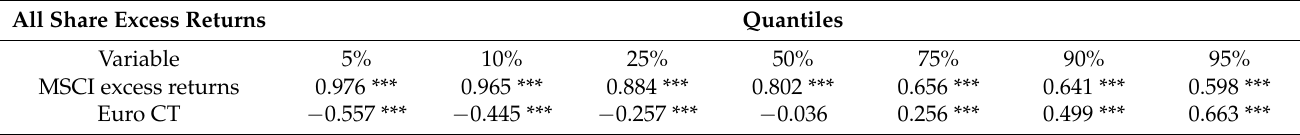
Figure 3. US dollar-denominated carry trade and the equity market. Note: The dotted line represents the 95% confidence interval; the solid lines show the coefficients for each quantile. Table 2. Equities market results analysis (euro carry trade).